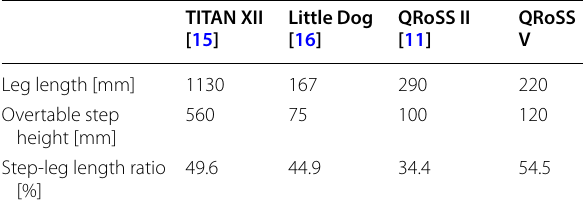
Table 2 Comparison of step-leg length